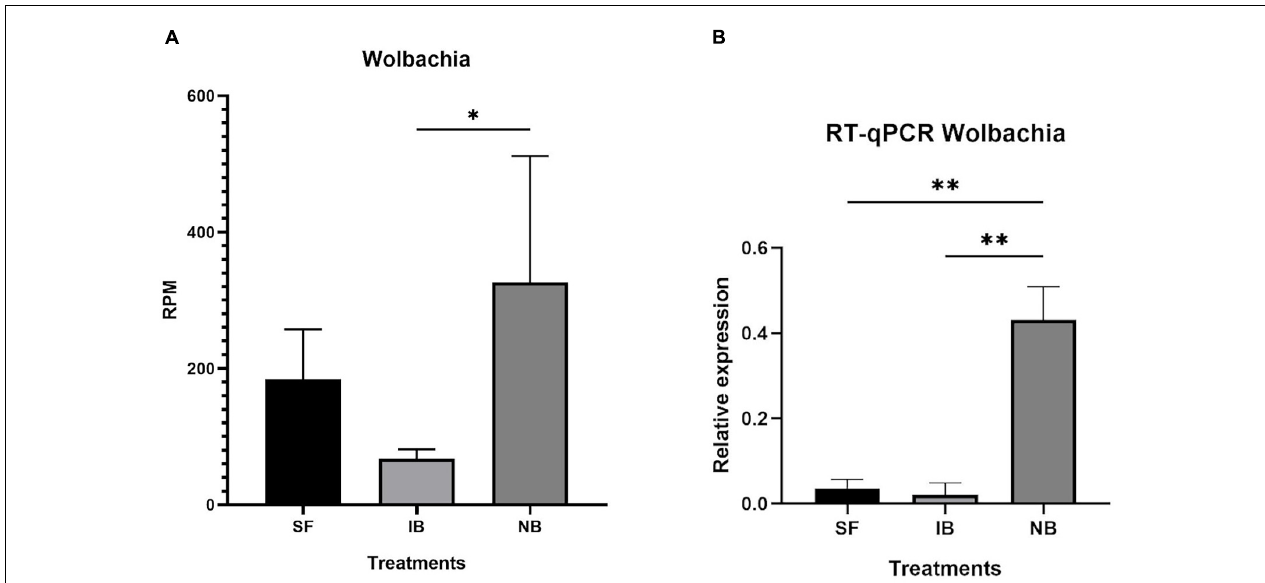
FIGURE 7 | Relative abundance of Wolbachia in Ae. albopictus after each feeding treatment. (A) Relative abundance of Wolbachia reads normalize as reads per million reads mapped in the Ae. albopictus genome. (B) RT-qPCR of relative abundance of Wolbachia groEL transcript compared to Ae. albopictus RP49. ∗ P < 0.05, ∗∗ P < 0.01; ANOVA.